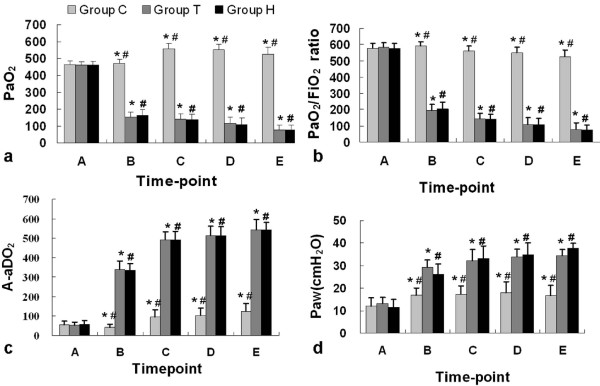
The change of pulmonary function. a, the change of PaO2; b, the change of P/F; c, the change of A-aDO2; d, the change of Paw. *, p < 0.05, group T comparing with group C; #, p < 0.05 group H comparing with group C.